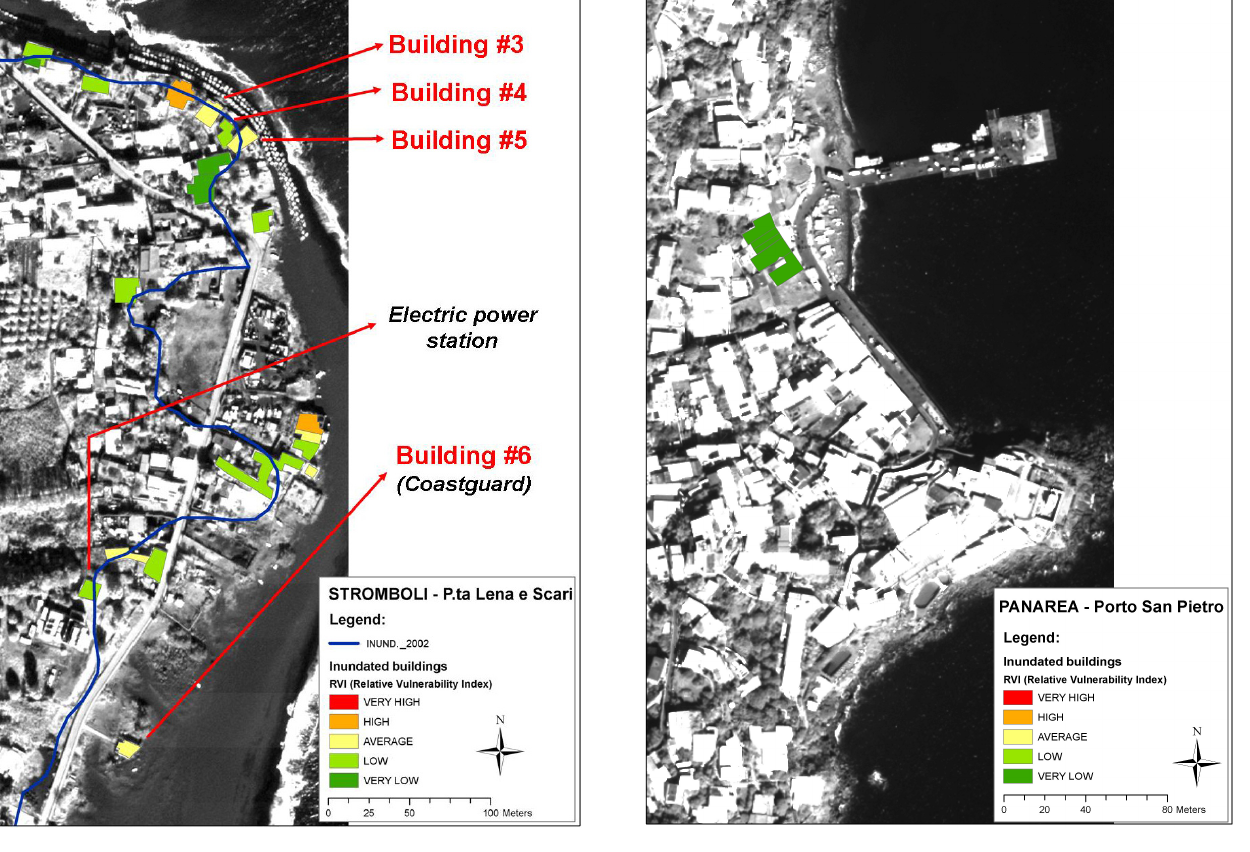
Fig. 7. Vulnerability map of the San Pietro Harbour (Panarea Is- land). The tsunami would inundate only 5 commercial buildings behind the main pier. Their RVI scores are all “very low”. The flow depth in this area would not exceed